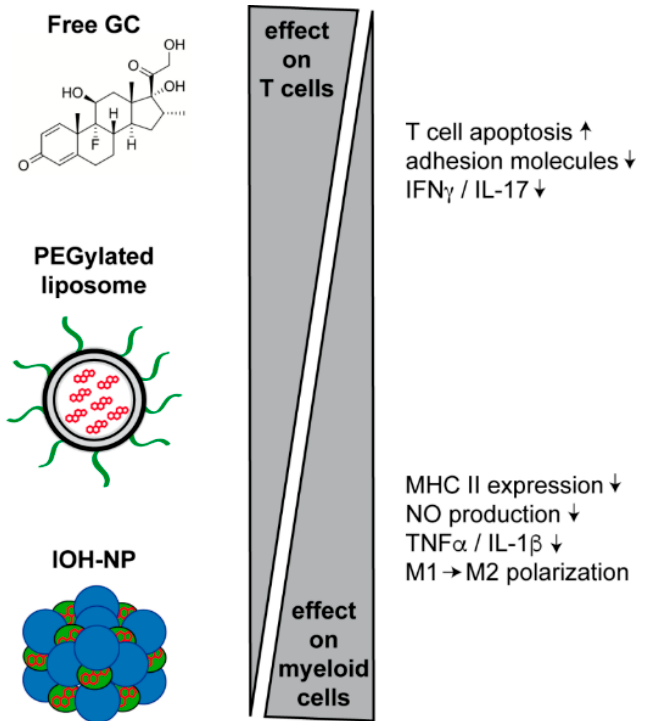
Figure 2. Comparison of different delivery vehicles in modulating EAE and immune cell functions in mice. Treatment of EAE in mice using free GC is mostly mediated via their effects on T cells, namely apoptosis induction and a reduction of adhesion molecules and cytokines such as IFN γ and interleukin (IL)-17. In contrast, GC delivered via PEGylated liposomes or inorganic–organic hybrid nanoparticles (IOH-NP) rather impact on myeloid cells by lowering MHC II surface levels and NO production, and inhibiting TNF α and IL-1 β expression. These effects result in a shift of macrophage polarization from M1 to M2. In general, the activity of IOH-NP depends more strictly on the targeting of myeloid cells than it is the case for PEGylated liposomes.